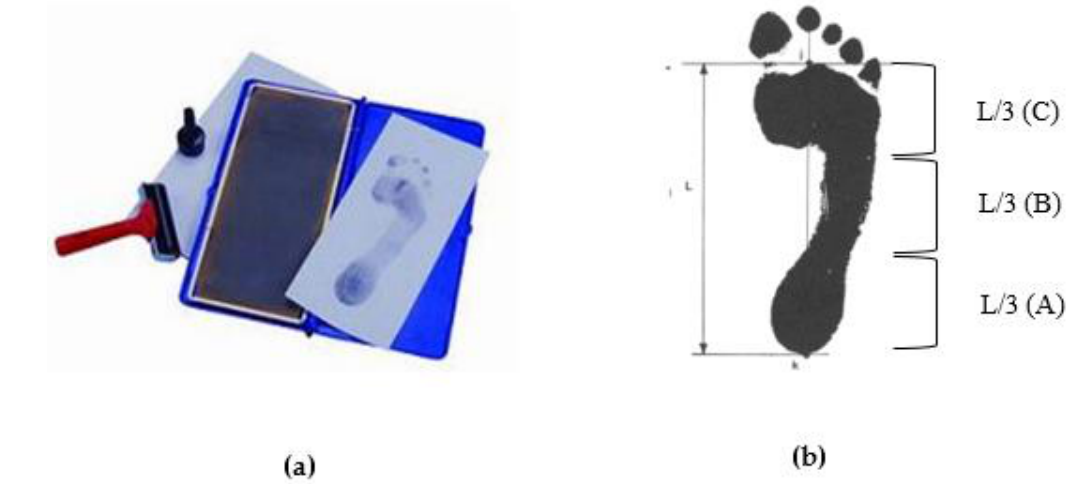
Figure 1 . Ink-type footprint printer ( a , b ) the method of arch index calculation [6].